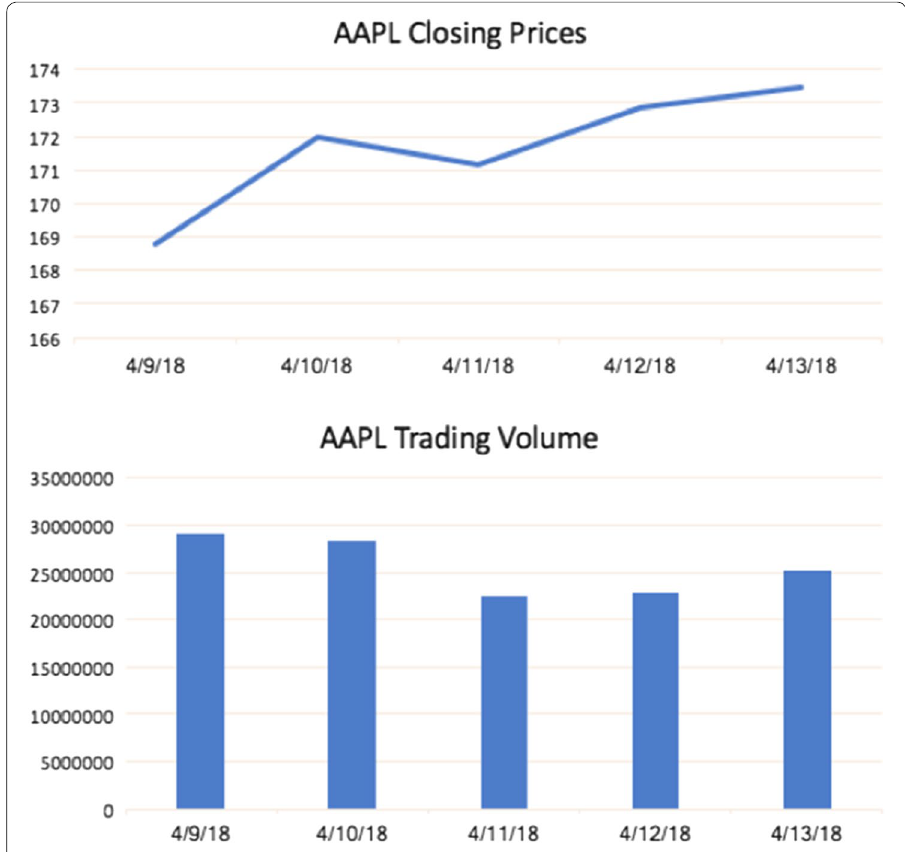
Fig. 2 Apple stock daily closing prices and trading volume for the week of April 9th,